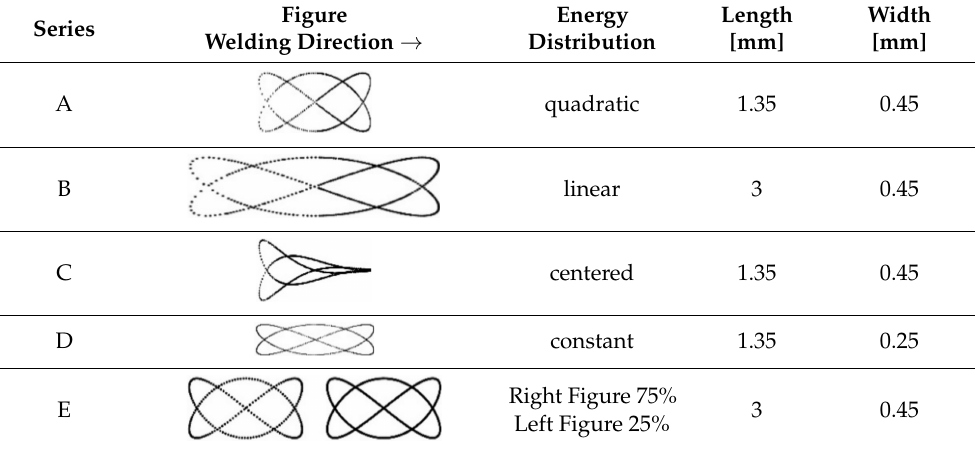
Table 2. Welding figures and their parameters for the second series of experiments. The energy distribution was symmetrical across the welding direction. All figures contained 1000 dots. Figure Energy Series Welding Direction →